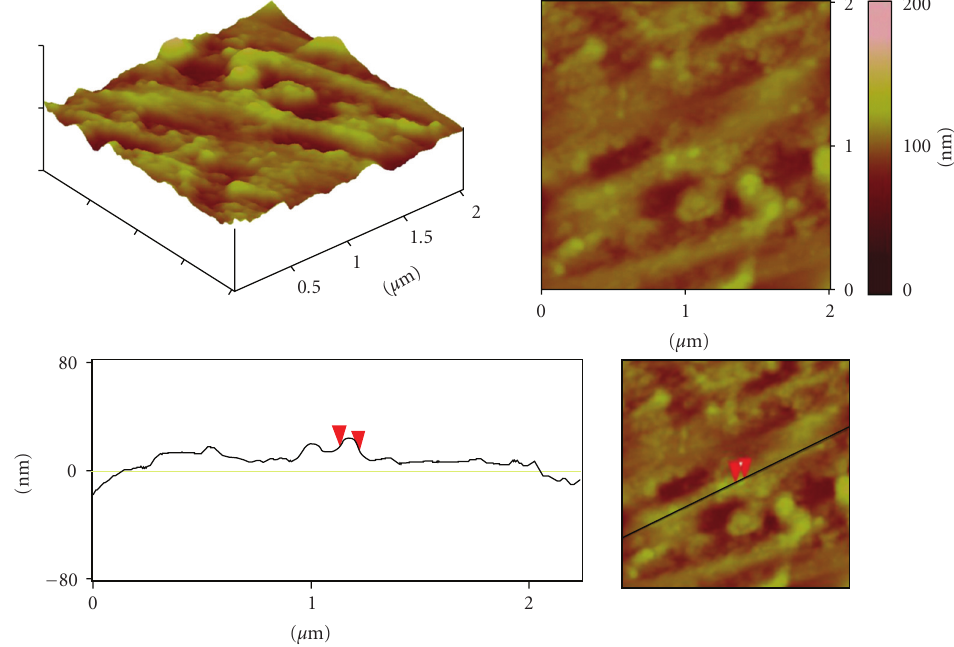
Figure 44: 3D and 2D AFM images of L-threonine crystal irradiated at 12 × 10 14 e/cm 2 .